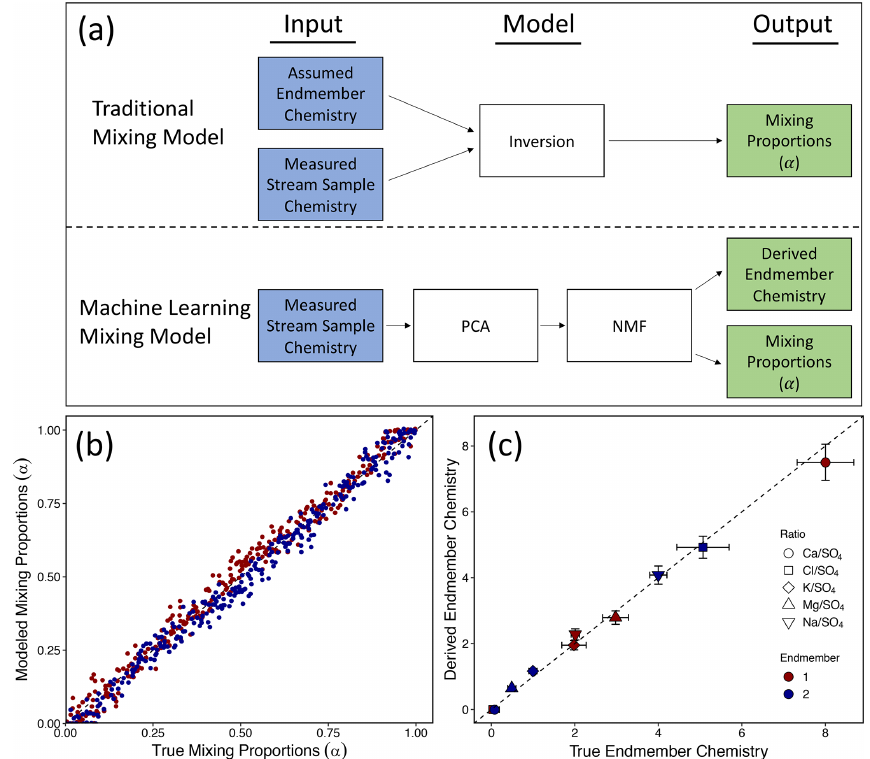
Figure 2. Schematic diagram showing the differences between a traditional mixing model and our machine-learning mixing model (a) . Notably, in the machine-learning mixing model, endmember chemistry is not assigned a priori but rather derived from patterns in the data. Results from using our machine-learning mixing model (i.e., NMF) on a synthetic dataset of known endmember chemistry and mixing proportions (i.e., α ) are shown in (b) and (c) . Using only the synthesized stream sample chemistries, the model adequately recovered the correct mixing proportions (b) and endmember chemistries (c) . The axes in (c) are the true concentration ratios of the endmembers and the NMF-derived concentration ratios of the